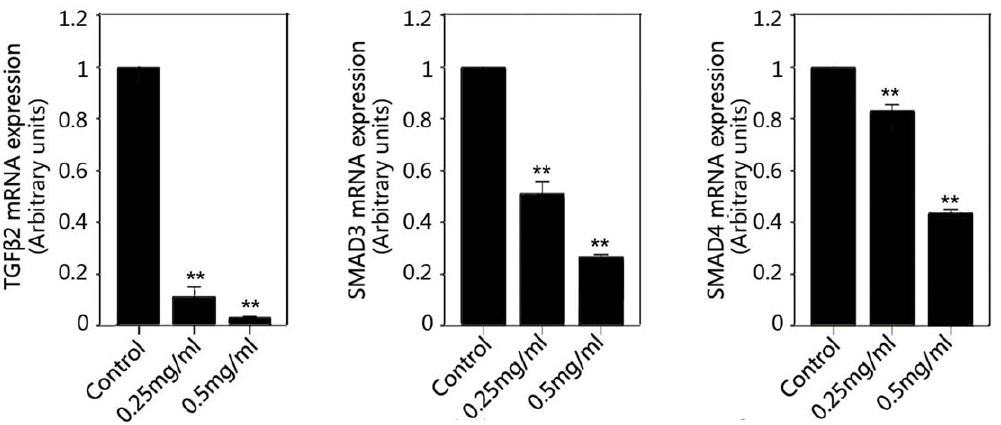
Figure 7. Inhibitory effect of pirfenidone on expression of TGF b 2 and SMADs mRNA in SRA01/04 cells. Real-time RT-PCR showed that pirfenidone reduced the levels of TGF b 2, SMAD3, and SMAD4 when compared with control cells. **P , 0.01 versus the corresponding value for control cells. Data are the mean 6 SD of triplicates from an experiment that was repeated with similar results.